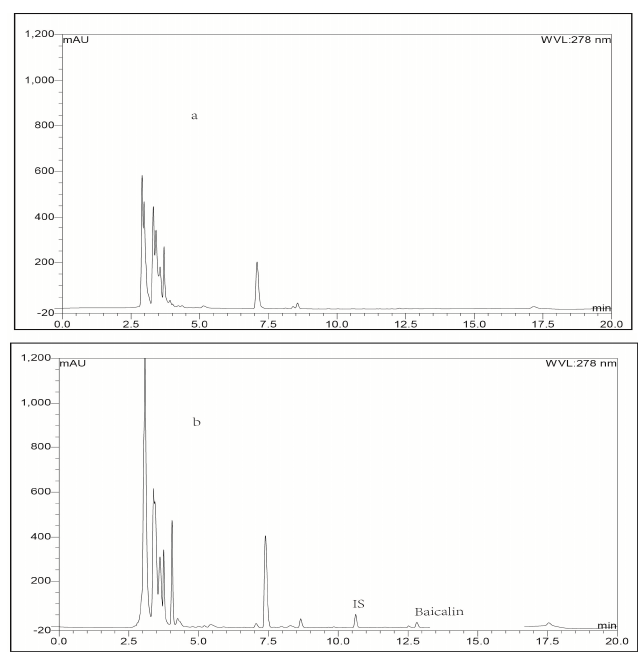
Figure 4. Representative LC-UV chromatograms obtained for blank heart tissue ( a ) and heart bio-sample collected from a rabbit at 0.25 h after intravenous administration of baicalin-loaded liposomes at a dose of 10 mg/kg + IS ( b ).